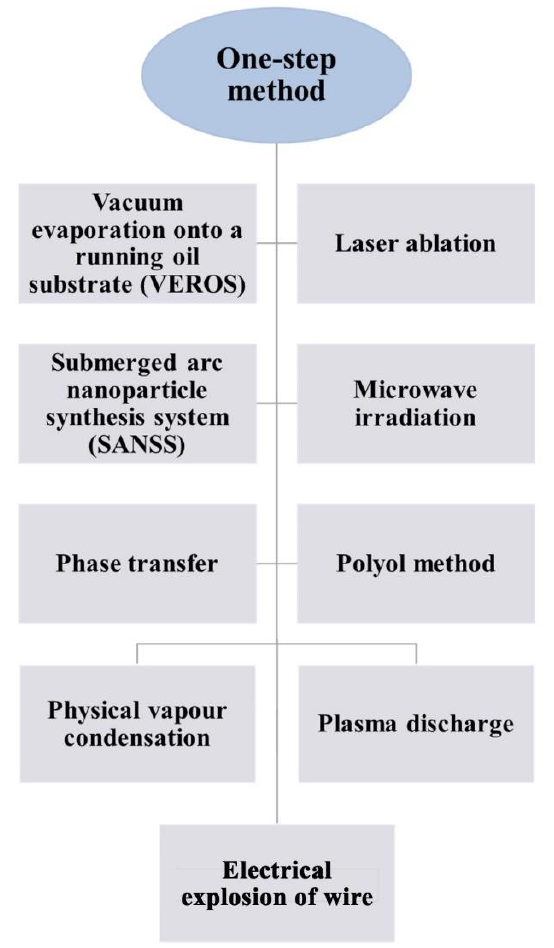
Figure 10. Different nanofluid production approaches that fall under the one-step method.